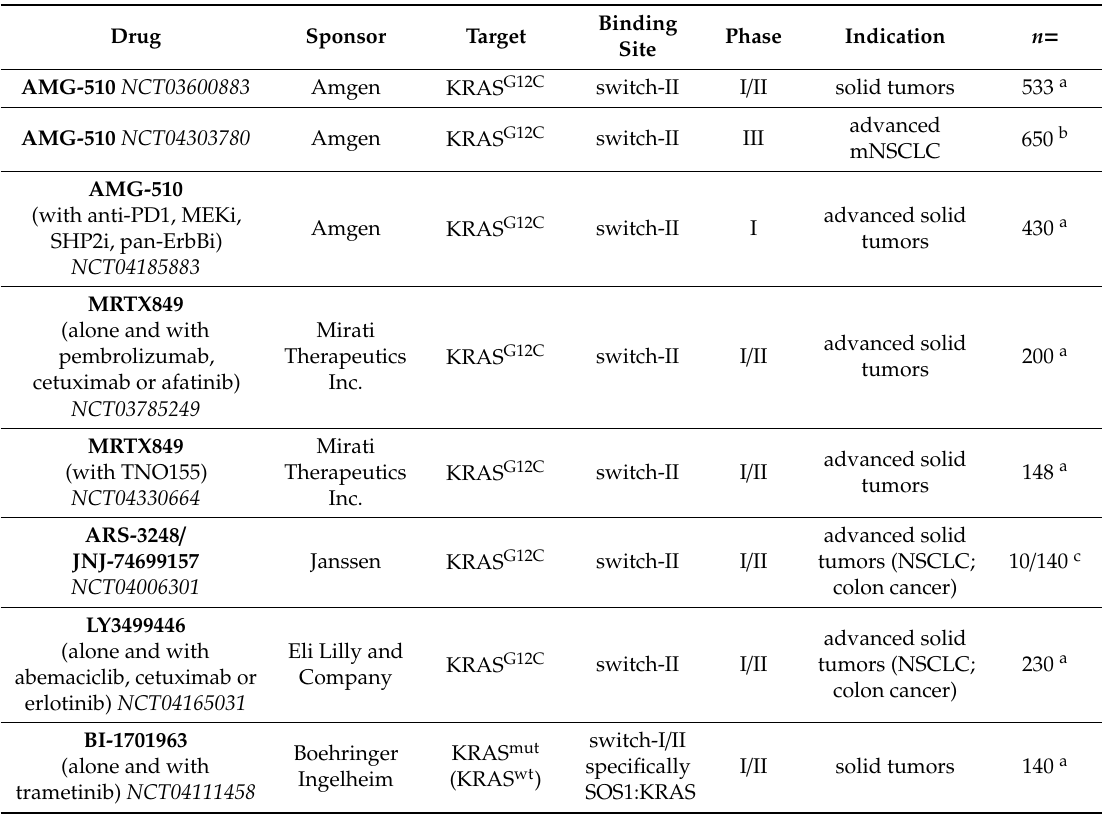
Table 1. Compounds directly targeting mutated KRAS currently in clinical trials, which include patients su ff ering from PDAC; first steps towards a paradigm shift in the treatment of KRAS-dependent tumor